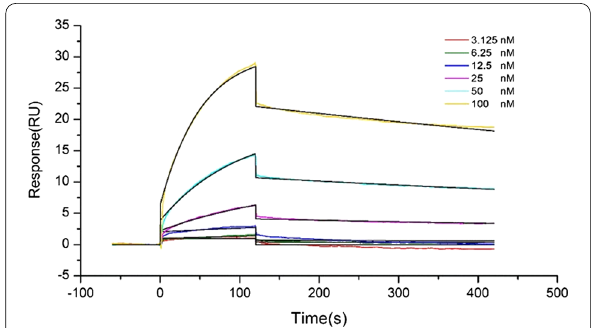
Fig. 10 Binding assy of mindin to TLR4 proteins by SPR. Different concen-trations of TLR4 protein (3.125, 6.25, 12.5, 25.0, 50.0, 100.0 nM) were performed to analyse the binding and dissociation rate constants between mindin and TLR4 proteins. The binding constant of them was calculated to evaluate protein